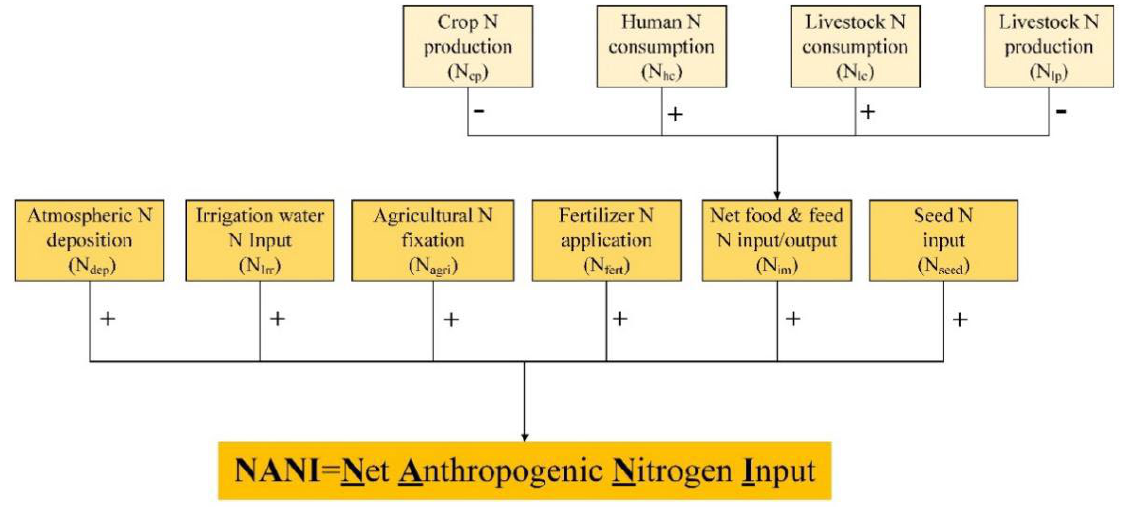
Figure 3. Methodology of NANI estimation method.